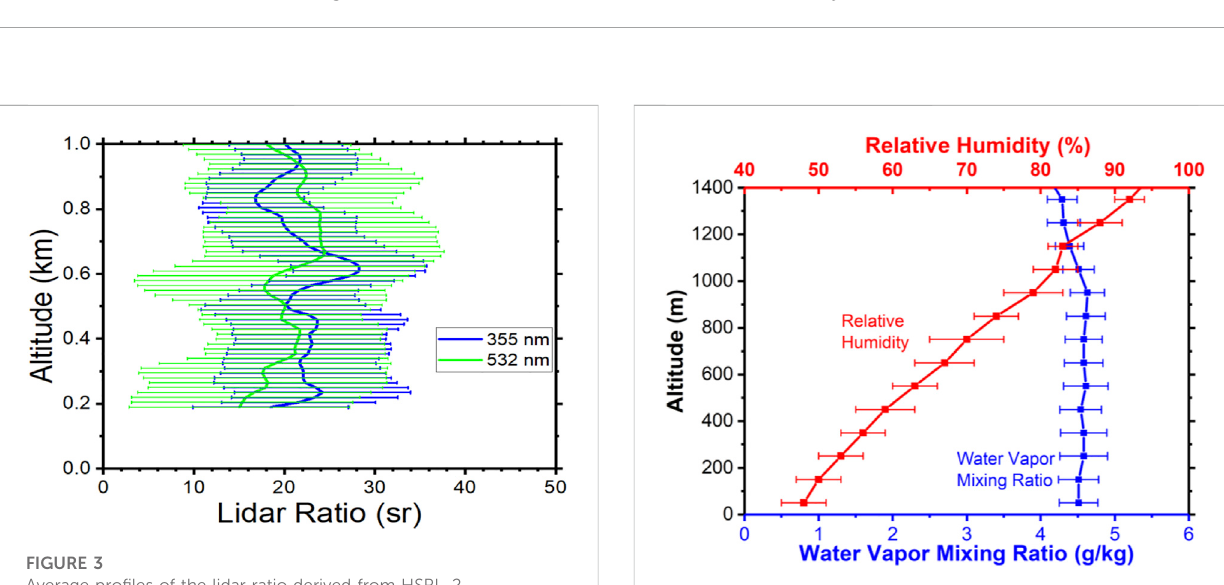
45 – 20:00 UT on 8 March 2020. These fi gures show pro fi les sampled every 0.5 s (~50 m). The pronounced increase in aerosol depolarization with decreasing RH is clearly shown in Figure 5B; Figures 5C,D show HSRL-2 aerosol backscatter and depolarization pro fi les along with the dropsonde RH pro fi le at the time of the